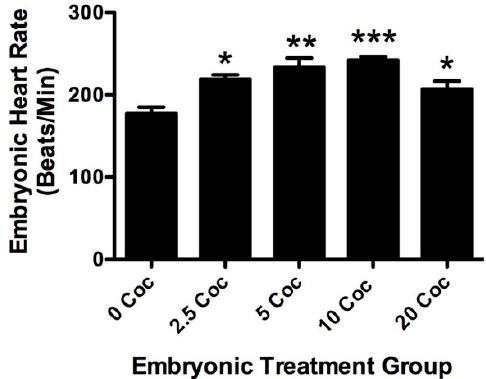
Figure 3. Cocaine treatment during development alters heart rate in zebrafish larvae. The histogram shows data from one of three experiments measuring heart rate in zebrafish larvae exposed to different doses of cocaine for three days and then allowed one day of recovery before testing. Cocaine induced a bell-shaped dose response curve in larval baseline heart rate, with the maximal effect seen after treatment with 10 mg/L (error bars indicate ± SEM, * indicates p < 0.05, ** indicates p < 0.01, *** indicates p < 0.001 compared to untreated controls, n = 8 for each condition).